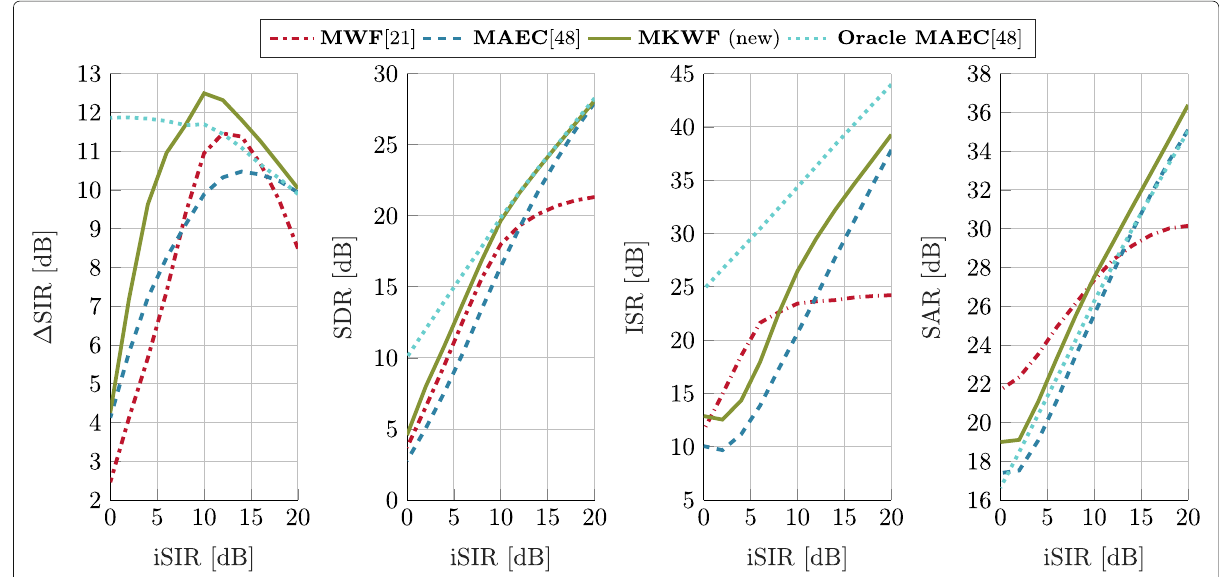
Fig. 7 Performance evaluation of the MWF, MAEC, new MKWF, and oracle MAEC in the considered meeting scenario. The abscissa denotes the iSIR [dB], while the ordinates show from left to right (cid:10) SIR[dB], SDR[dB], ISR[dB], and SAR[dB], respectively. Figure best seen on the